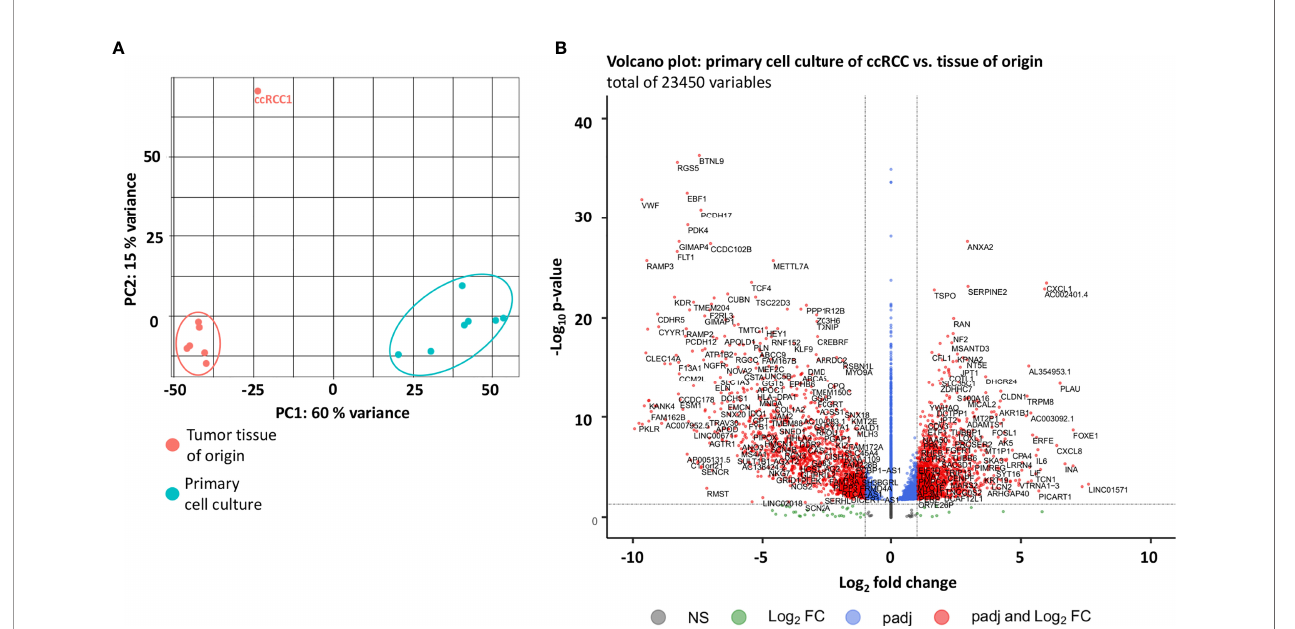
FIGURE 1 | RNA-sequencing: alternated pathways in ccRCC primary cell cultures compared to the tissue of origin. (A) PCA plot of mRNA expression pro fi les in seven ccRCC primary cell cultures compared to the tumor tissue (tissue of origin). Primary cell cultures as well as the tissue of origin clustered, revealing a close genetic similarity within their group, with the exception of ccRCC1 (outlier). This renal cell carcinoma displayed no histological abnormalities, but harbored a VHL gene mutation (c.491 A>T, missense substitution, Supplementary Table 5 ). It also displayed slight differences in the top 50 dysregulated genes which a highly aberrant expression of ALDOB and FBG (see Figure 2 ). (B) Volcano plot of the dysregulated genes in primary cell cultures compared to the tissue of origin. A total of 23450 genes displayed genetic alterations. The -Log10 p-value on the y axis displays the statistical signi fi cance, Log2 fold change on the x axis reveals over- or reduced expression of the gene. The blue dots represent genes with signi fi cant gene alterations within a Log2 fold change of -1 and 1, respectively. The green dots represent gene alterations with p > 0.05 (dashed line). NS = gene alterations, neither signi fi cant (p > 0.05) nor with Log2 fold change < -1 or >